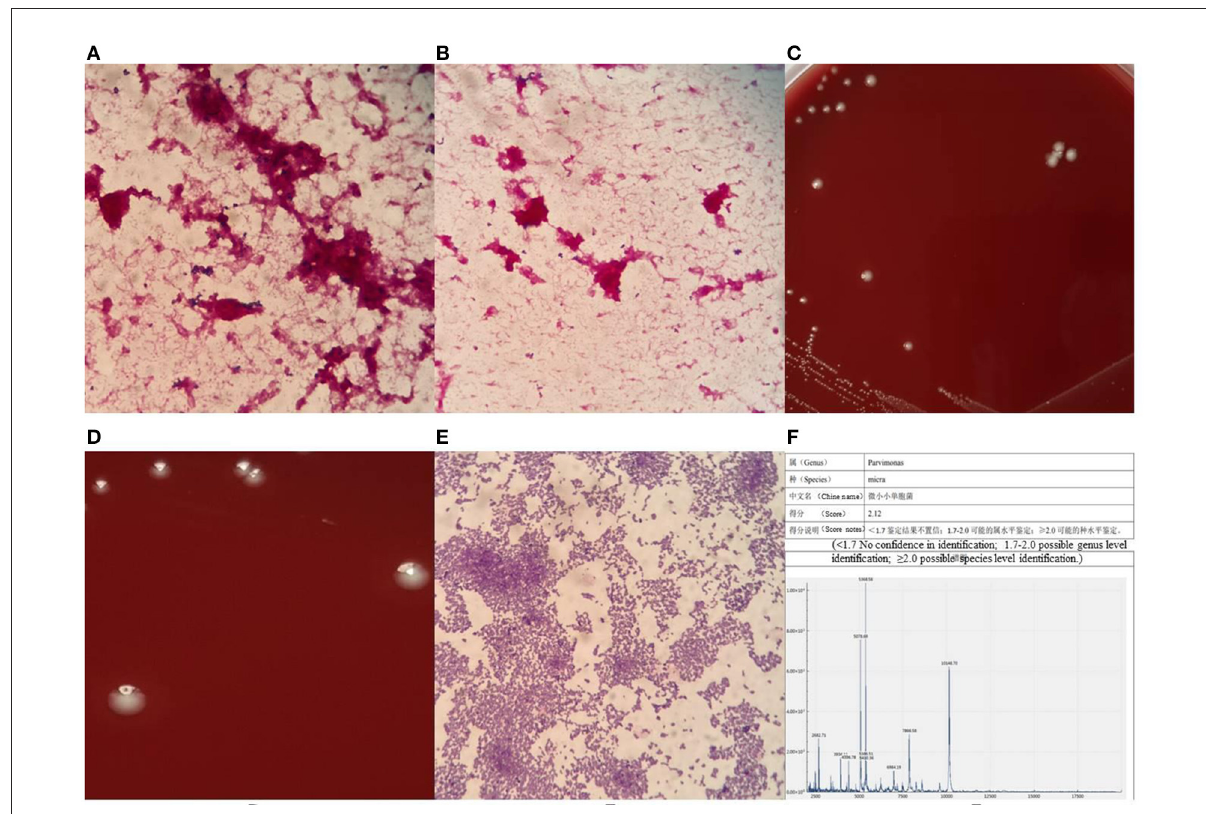
FIGURE1 Gram stain of blood smear under microscope (A) × 1000, morphological distribution of P. micra (B) × 1000, morphological characteristics of colonies of P. micra (C,D), Gram-stained morphology of P. micra colonies (E) × 1000, mass spectrometer identification result (F) .